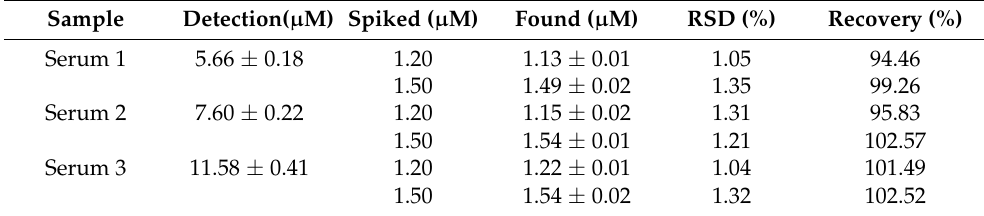
Table 2. Determination of bilirubin in human serum samples (n = 3).